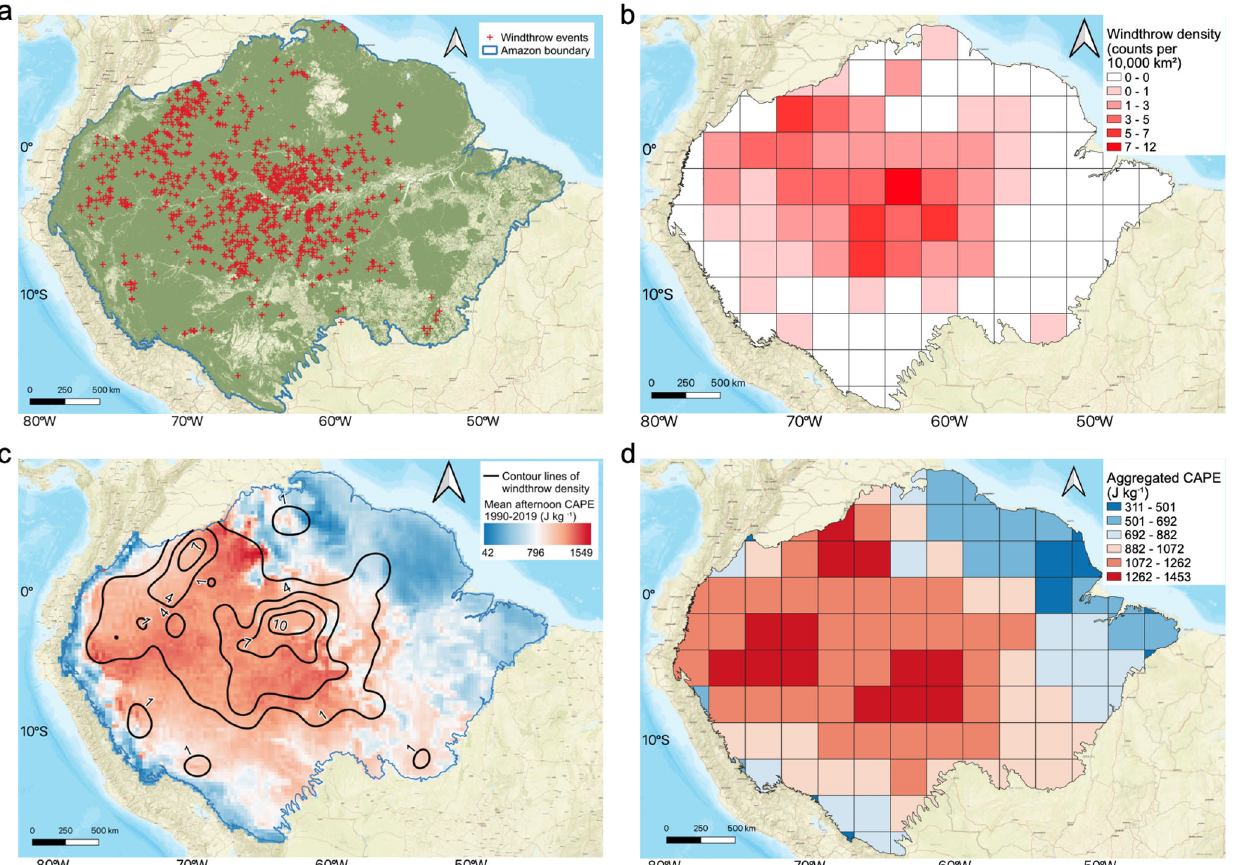
Fig. 1 | The spatial pattern of windthrows and mean afternoon convective available potential energy (CAPE). a 1012 Windthrow events identi fi ed manually using Landsat 8 images, green color in the background represents forested area. b Windthrow density in 2.5°×2.5° grids. c Contour lines of windthrow density